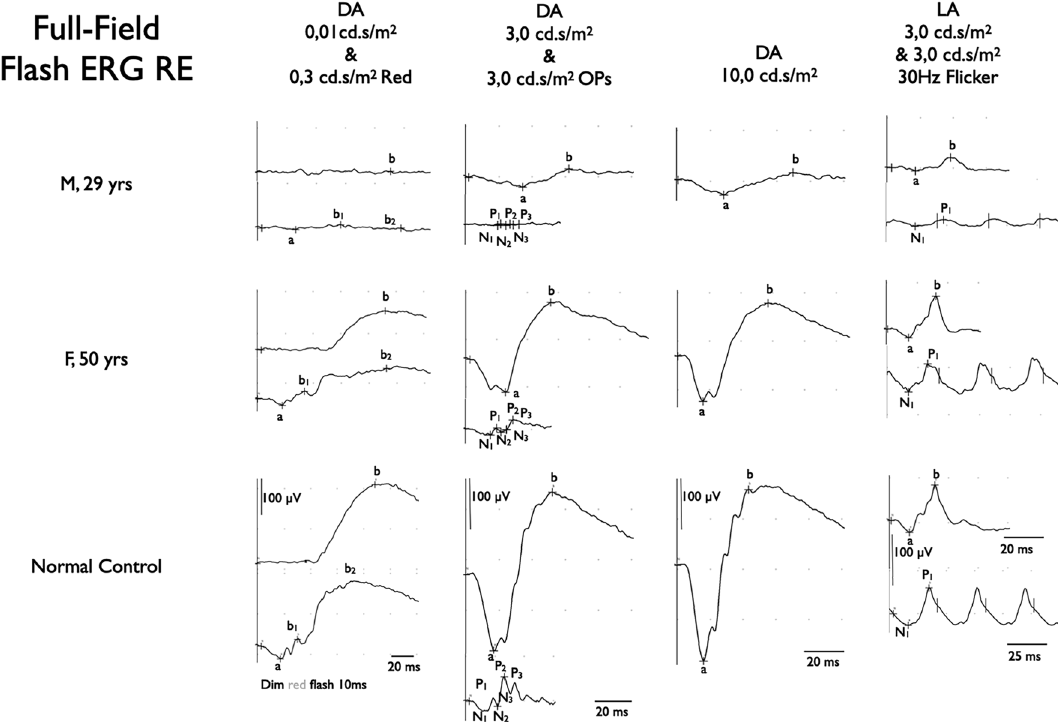
Figure 3. ISCEV standard full-field flash electroretinogram (ERG). (Top traces) Right eye (RE) of proband (III.1) at age 29. Scotopic ERG: complete absence of rod specific response to a dim white flash (0.01 cd.s/m2); residual response to slightly higher intensity red flash (0,3 cd.s/m2); responses to high intensity flashes (3.0 cd.s/ m2 and 10.0 cd.s/m2) show significant reduction of amplitudes and major delay in peak times. Photopic ERG: response to a transient, high-intensity flash (3.0 cd.s/m2) also shows significant reduction in amplitudes and a delay of responses. This is confirmed by response to a 30 Hz high intensity (3.0 cd.s/m2) flicker stimulus. (Middle traces) RE of the mother of the proband (II.1) at age 50. Scotopic rod specific ERG: reduction of amplitude of rod specific response to a dim white flash (0.01 cd.s/m2) to about two thirds of normal; response to slightly higher intensity red flash (0.3 cd.s/m2) shows conserved response of cone-specific part (b1), with similar decrease to two thirds of normal amplitude of rod-specific response (b2); responses to high-intensity flashes (3.0 cd.s/m2 and 10.0 cd.s/m2) show similar reduction to two thirds of normal for both a- and b-waves with only minor delay of responses. Photopic ERG: response to a transient high-intensity flash (3.0 cd.s/m2) shows mild delay of b-wave (right column top trace) and mild delay to a 30 Hz high intensity (3.0 cd.s/m2) flicker stimulus (right column bottom trace). (Bottom traces) Normal reference traces of a healthy control